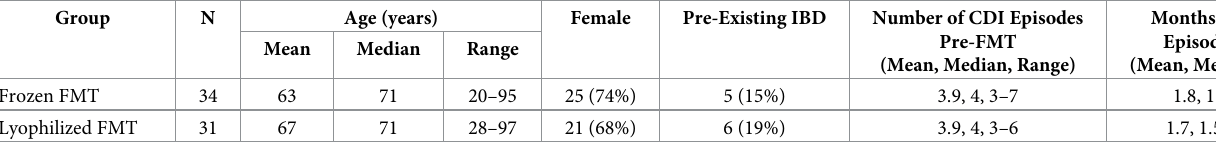
Table 1. Characteristic of subjects with recurrent CDI at enrollment for FMT.